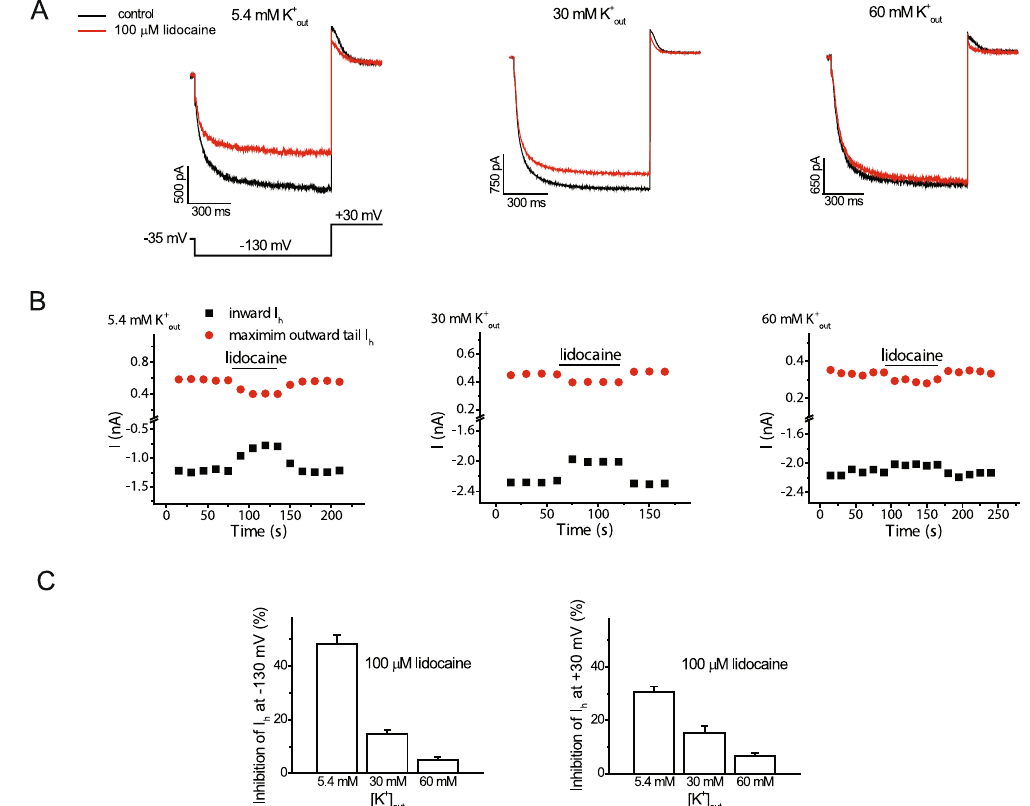
Figure 4. Elevation of extracellular potassium concentration opposes the effects of lidocaine on HCN1- mediated I h amplitude. ( A ) Representative traces of inward steady-state and outward I h under control conditions and following application of 100 µ M lidocaine with a concentration of 5.4 mM, 30 mM, or 60 mM of potassium in the extracellular solution. Activation voltage pulses (1 s) producing inward steady-state current, followed by by a repolarization pulse to + 30 mV to generate outward current, were applied with an interval of 15 s ( B ). Amplitudes of steady-state inward I h ( − 130 mV) and maximum outward I h ( + 30 mV) from individual cells with 5.4 mM, 30 mM, or 60 mM potassium in the extracellular solution under control conditions and in the presence of lidocaine (100 µ M). The horizontal bar denotes the duration of lidocaine exposure. Note that the inhibition of inward and outward I h by lidocaine was reversible. ( C ) Bar graphs of percent inhibition of I h (left, − 130 mV; right, + 30 mV) by 100 mM lidocaine at different concentrations of extracellular potassium. Lidocaine produced reversible inhibition of I h at − 130 mV (inward) or + 30 mV (maximum outward current) by 48.2 ± 3.4 and 30.2 ± 2.1%, respectively, (n = 6; paired t -test, P < 0.001) at 5.4 mM extracellular potassium. The percentage of I h inhibited by this concentration of lidocaine was less at 30 and 60 mM extracellular potassium (n = 4–6; ANOVA, P < 0.001 at both voltages; n = 4–6 cells for each